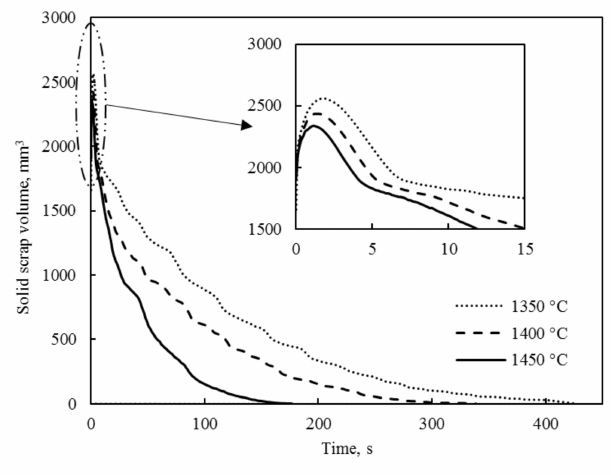
Figure 9. The volume variation of the solid scrap during the melting process.